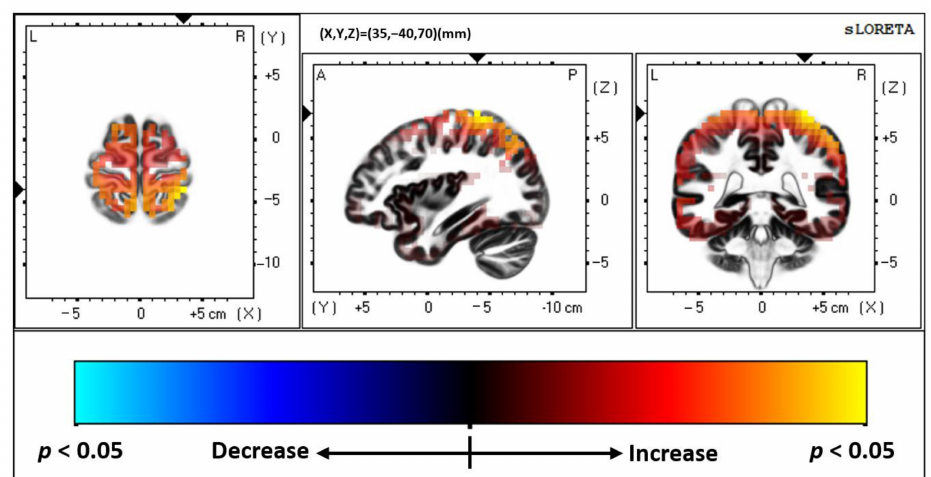
Figure 3. sLORETA multisensory response, ADHD vs. Controls. Slice Viewer highlighting region of greatest neural activity difference between controls and those with ADHD. Views, from left to right, include a transverse, sagittal, and coronal cross-sectional area. sLORETA analyses found that controls had greater activity in the region highlighted in yellow.